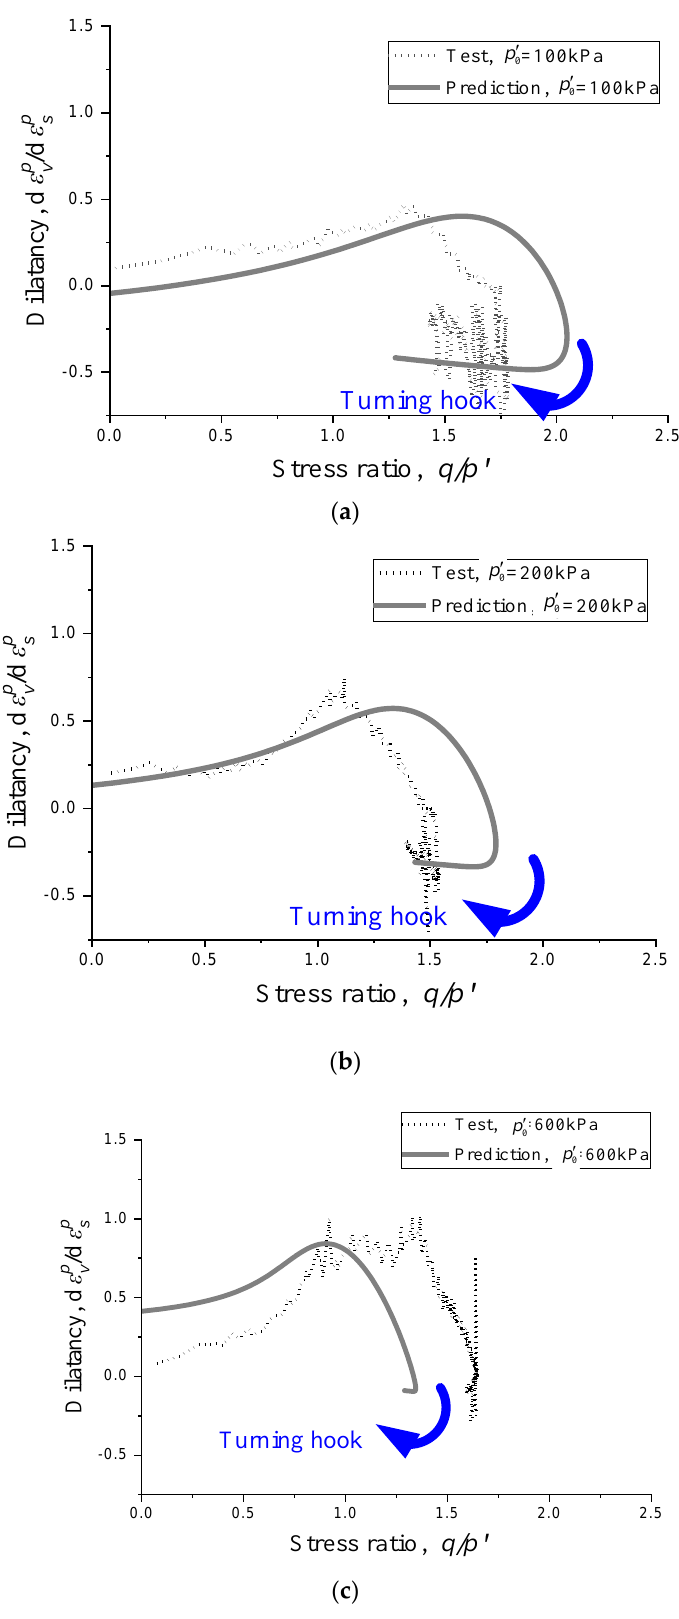
Figure 13. Prediction of the turning hooks of the stress − dilatancy curves: ( a ) 0 p =100 kPa, ( b ) 0 p =200 kPa, and ( c ) 0 p =600 kPa.